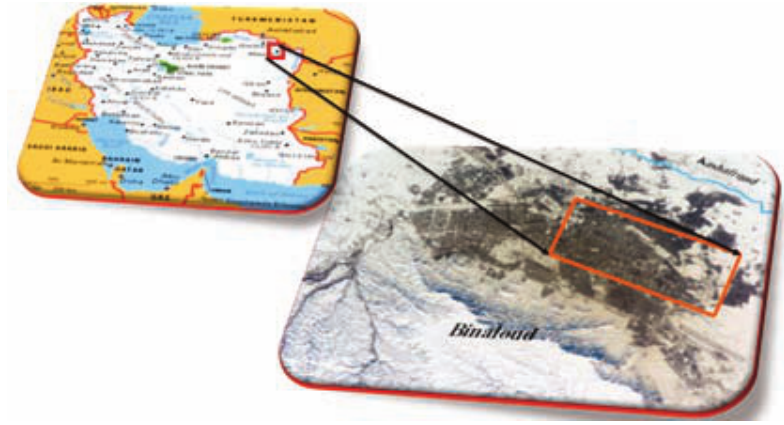
Figure 1. Satellite image of Mashhad City, in the north-east of Iran.